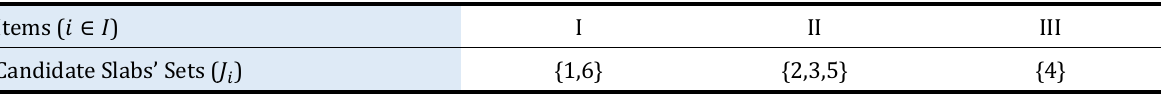
Fig. 1. An example of order: the general case